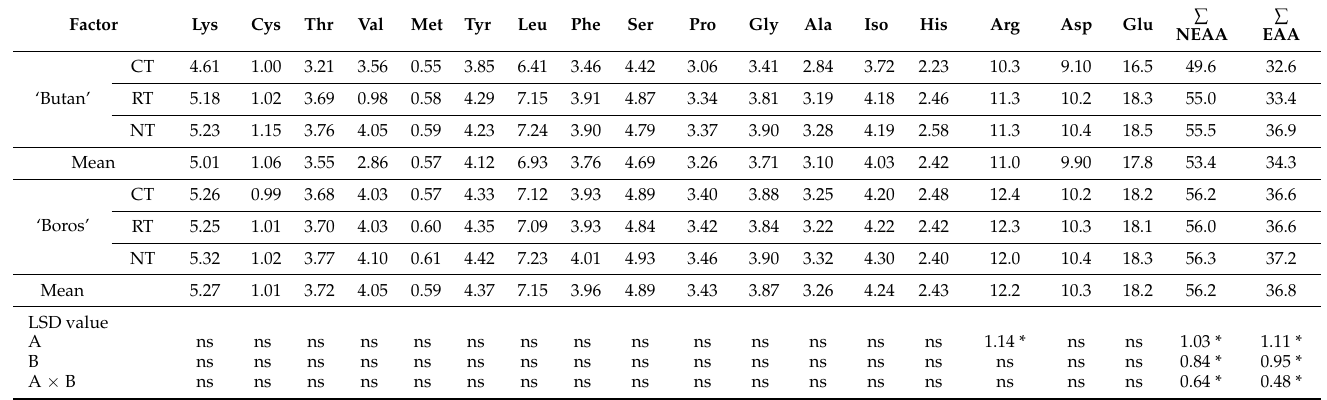
Table 4. Amino acid profile (g 16 g − 1 N) of white lupin (WL) depending on variety and tillage